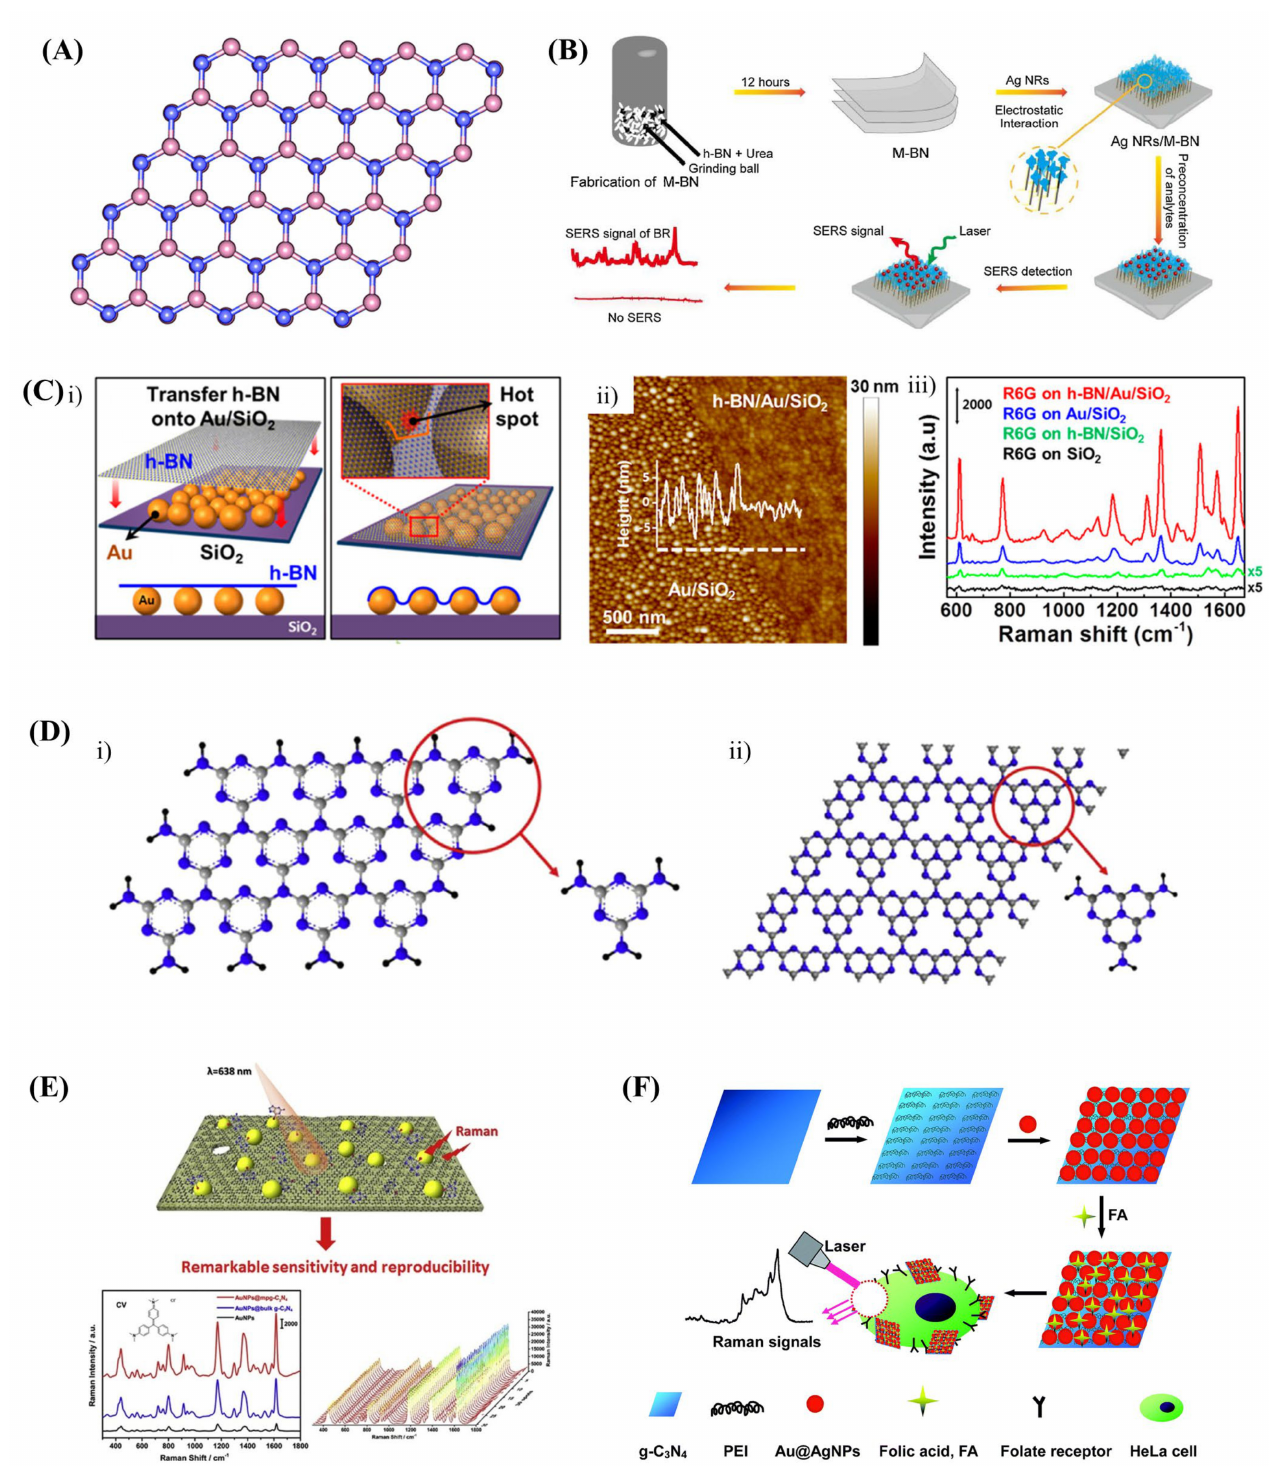
Figure 4. ( A ) Structure of 2D h-BN layer [152]. ( B ) Schematic diagram of fabrication of AgNRs/h-BN hybrid SERS substrate for the detection of bilirubin [74]. ( C ) ( i ) Schematic illustration, ( ii ) AFM image of h-BN layer on AuNPs and ( iii ) SERS spectra of Rh6G on different substrates [151]. ( D ) 2D layered ( i ) s-triazine and ( ii ) heptazine structures of g-C 3 N 4 [153]. ( E ) AuNPs on the mesoporous g-C 3 N 4 SERS substrate for the detection of 6-thioguanine [154]. ( F ) Schematic illustration of the fabrication of g-C 3 N 4 /Au@AgNPs hybrid as a SERS probe and its application in cancer diagnostics